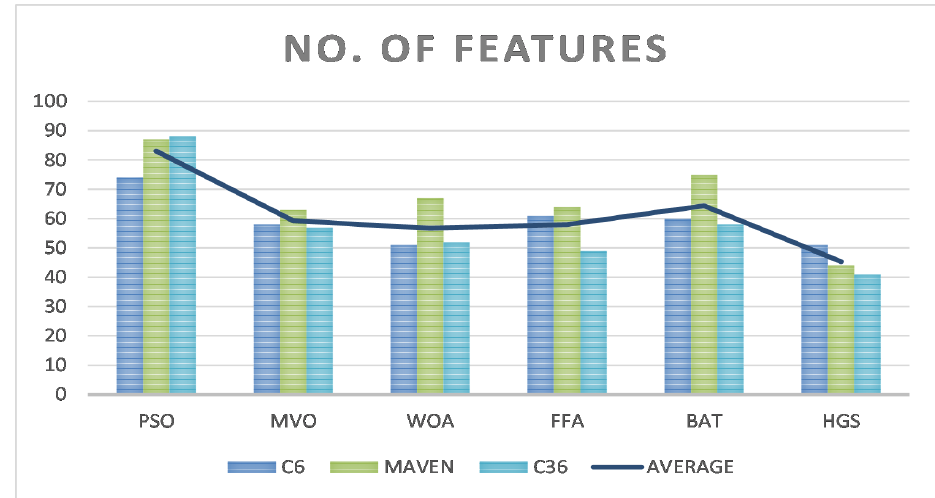
Figure 8. Number of selected features of each FS method.